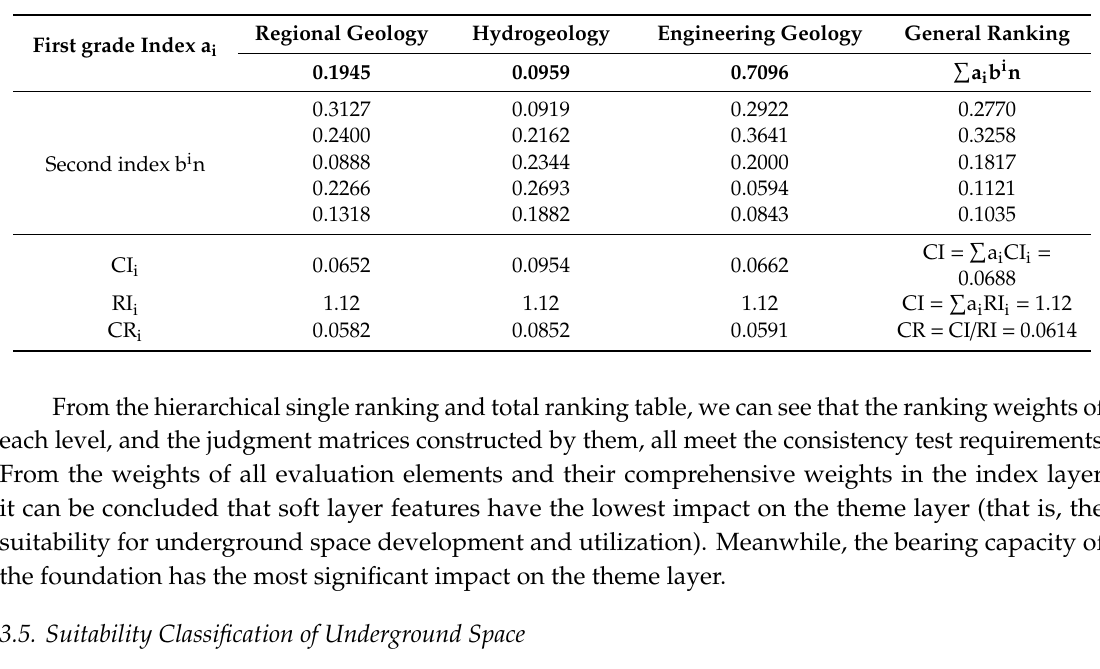
Table 8. Hierarchical total sorting and consistency